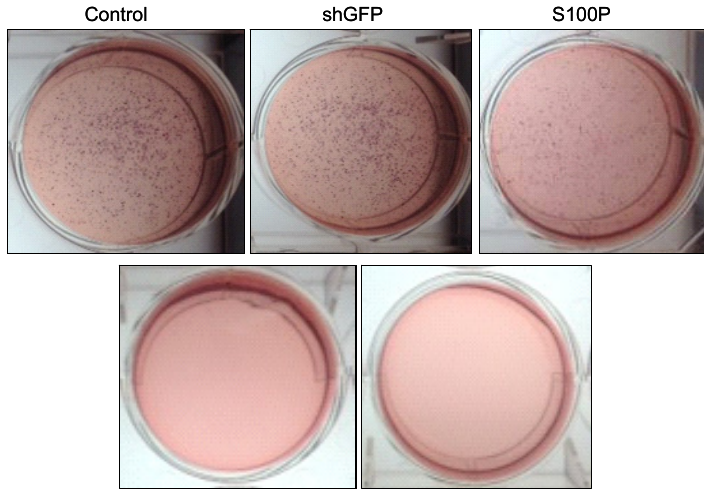
Figure 4. Anchorage independent growth of LN-229 cells treated with DEHP alone and in combination with S100P knockdown. Colony formation was visualized after staining the cells with p-iodonitrotetrazolium violet